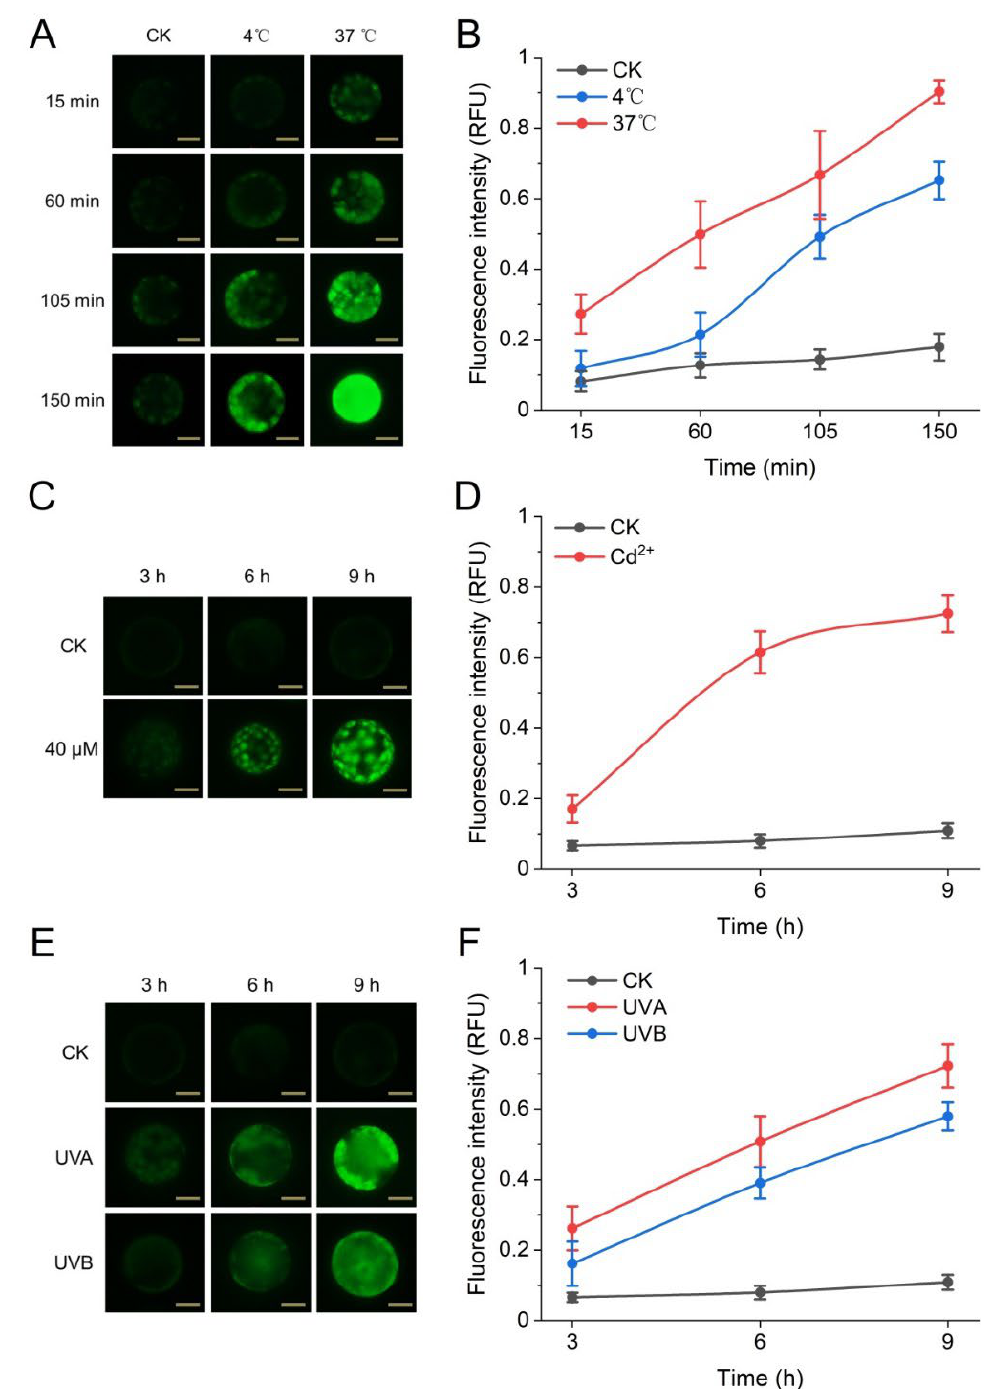
Figure 3. Redox status of Arabidopsis protoplasts under environmental stress. ( A ) Fluorescence images of protoplasts at different temperatures with a scale of 25 µ m; ( B ) fluorescence intensity of protoplasts at different temperature stresses; ( C ) fluorescence images of protoplasts under Cd 2+ treatment with a scale of 25 µ m; ( D ) fluorescence intensity of protoplasts under Cd 2+ ; ( E ) fluorescence images of protoplasts under UV treatment with a scale of 25 µ m; ( F ) fluorescence intensity of protoplasts under